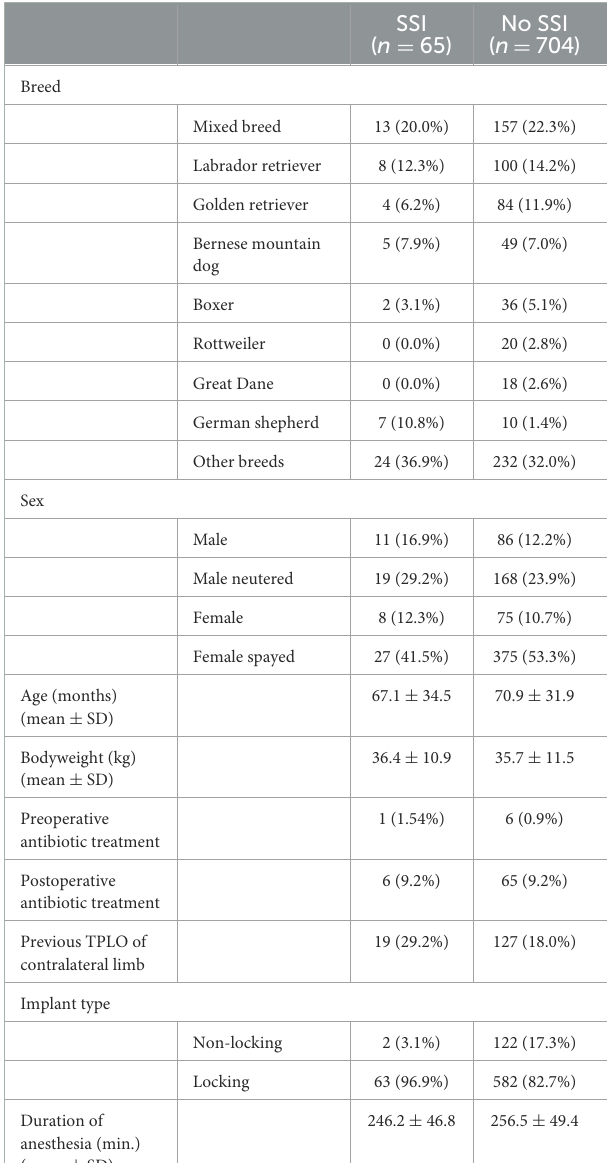
TABLE 1 Demographics of patients undergoing 769 TPLO with and without